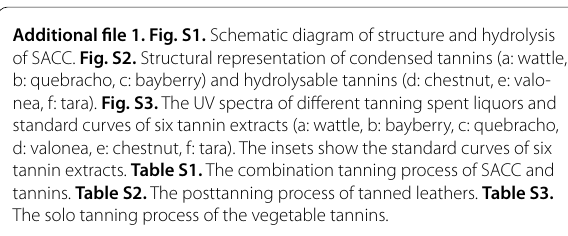
tannin extracts. Table S1. The combination tanning process of SACC and tannins. Table S2. The posttanning process of tanned leathers. Table S3. The solo tanning process of the vegetable